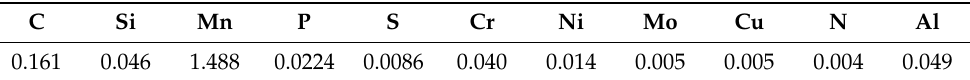
Figure 8. Mess & Feinwerktechnic GmbH MFA25 extensometer.